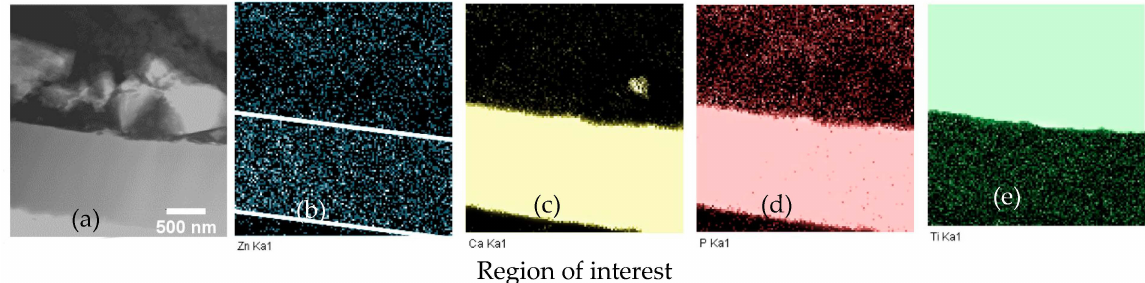
Figure 4. Energy-dispersive X-ray (EDX) element mapping of Zn-CaP coating on Ti–6Al–7Nb substrate in TEM lamella: